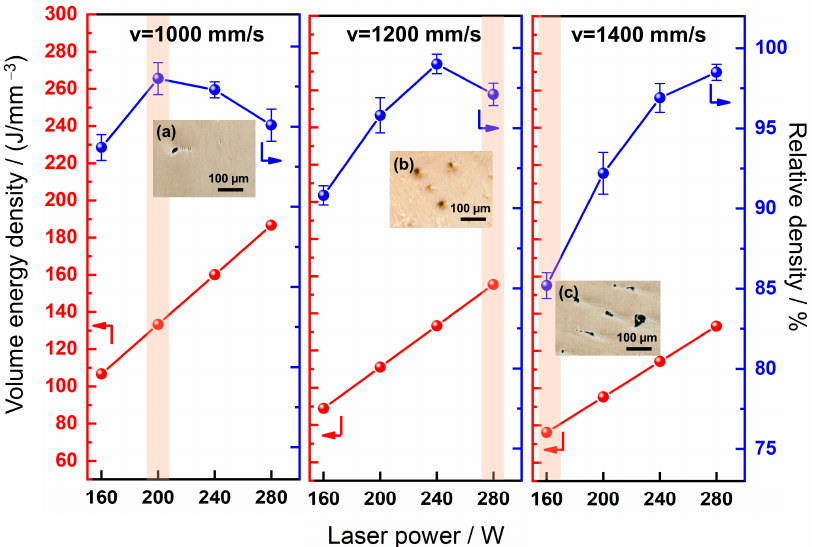
Figure 1. Volume energy density and relative density of Ti6Al4V alloy for different laser power and scanning rate. The inserts show metallographs of the specimens at ( a ) v = 1000 mm/s, P = 200 W; ( b ) v = 1200 mm/s, P = 280 W; and ( c ) v = 1400 mm/s, P = 160 W.